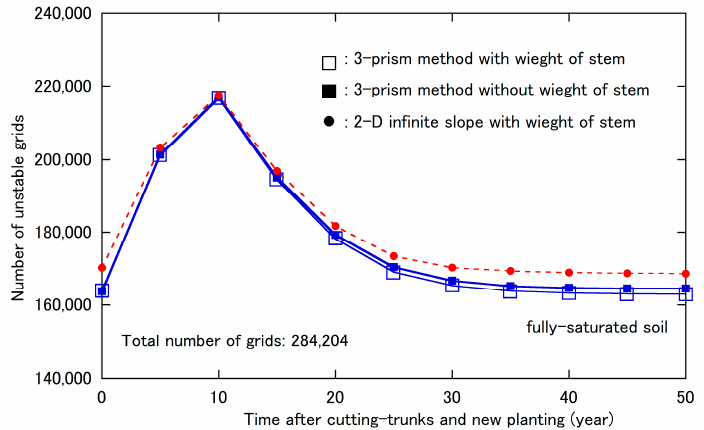
Figure 10. Changes in the number of unstable grids according to slope-stability analysis over time (after Japanese cedar stump-cutting and new planting up to 50